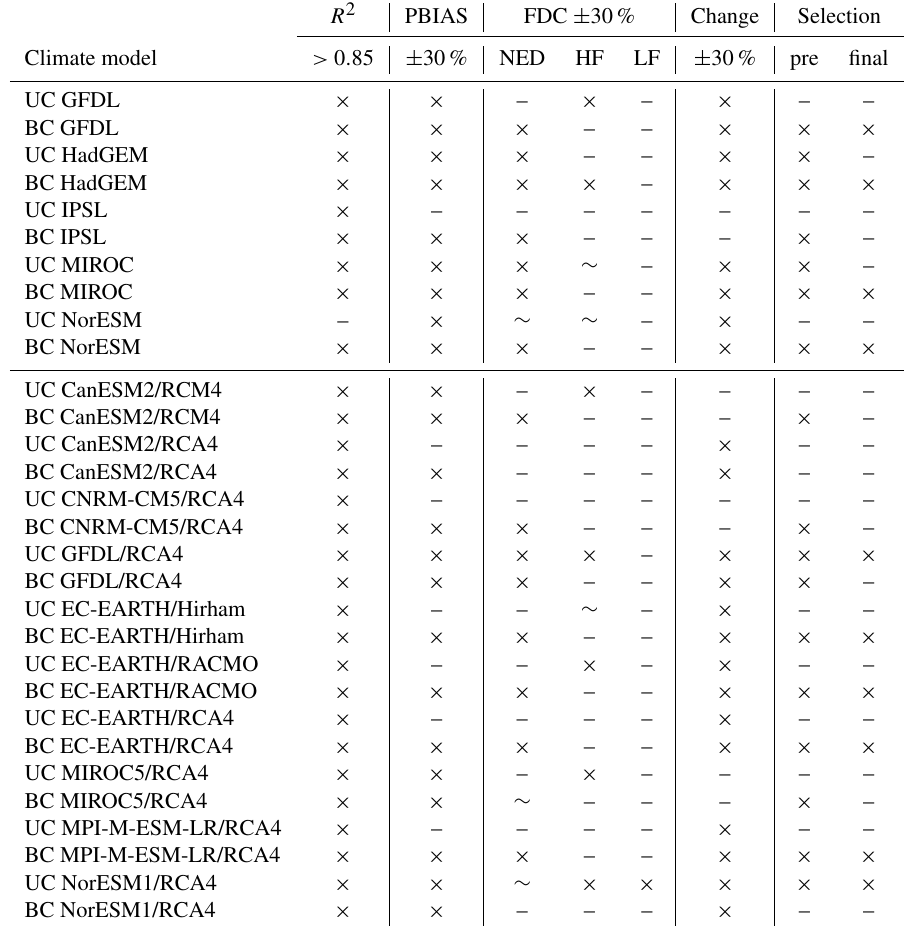
Table 1. Selection of uncorrected (UC) and bias-corrected (BC) Earth system models (ESMs) and regional climate models